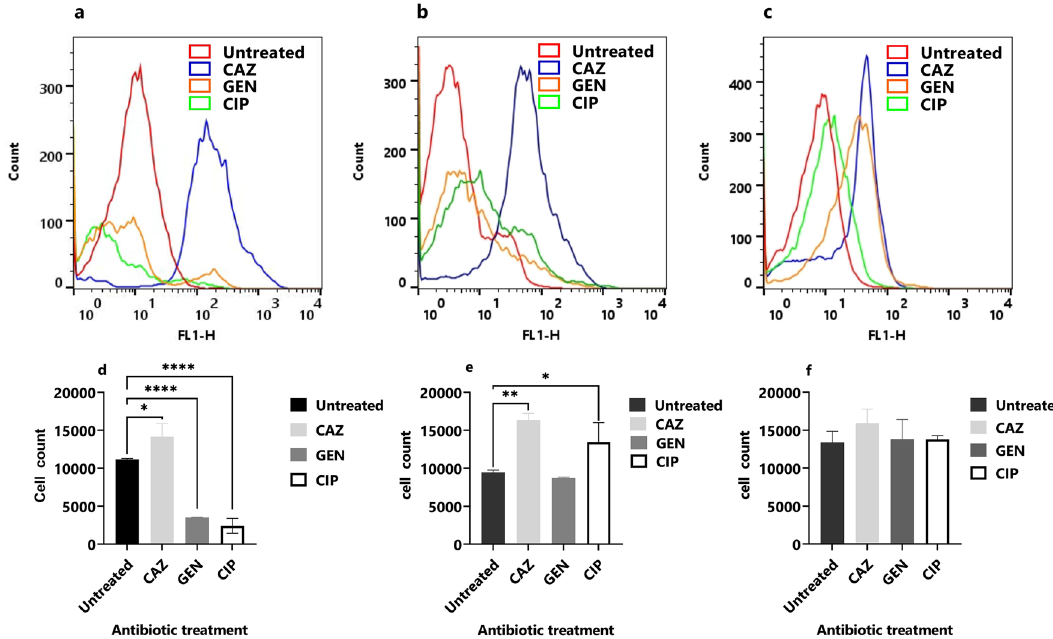
Figure 2. Cellular redox activity of planktonic cells. The flow cytometry of ( a ) PAO1, ( b ) TP-10 and ( c ) ST-13 isolate was done using RSG staining after 4 h of antibiotics treatment (CAZ, GEN, and CIP). Untreated was used as a control. ( d–f ) The quantitative data of RSG-positive cells (in PAO1, TP-10 and ST-13) using flow cytometry analysis after treatment with respective antibiotics were compared to the untreated control. CAZ: ceftazidime, GEN: gentamicin, and CIP: ciprofloxacin. The corresponding data represent the mean ± standard deviation. The experiment was performed in three biological triplicates for each strain. Statistical analysis was performed using a one-way ANOVA, which was * P < 0.05, and ** P < 0.01, *** P < 0.001, **** P < 0.0001.